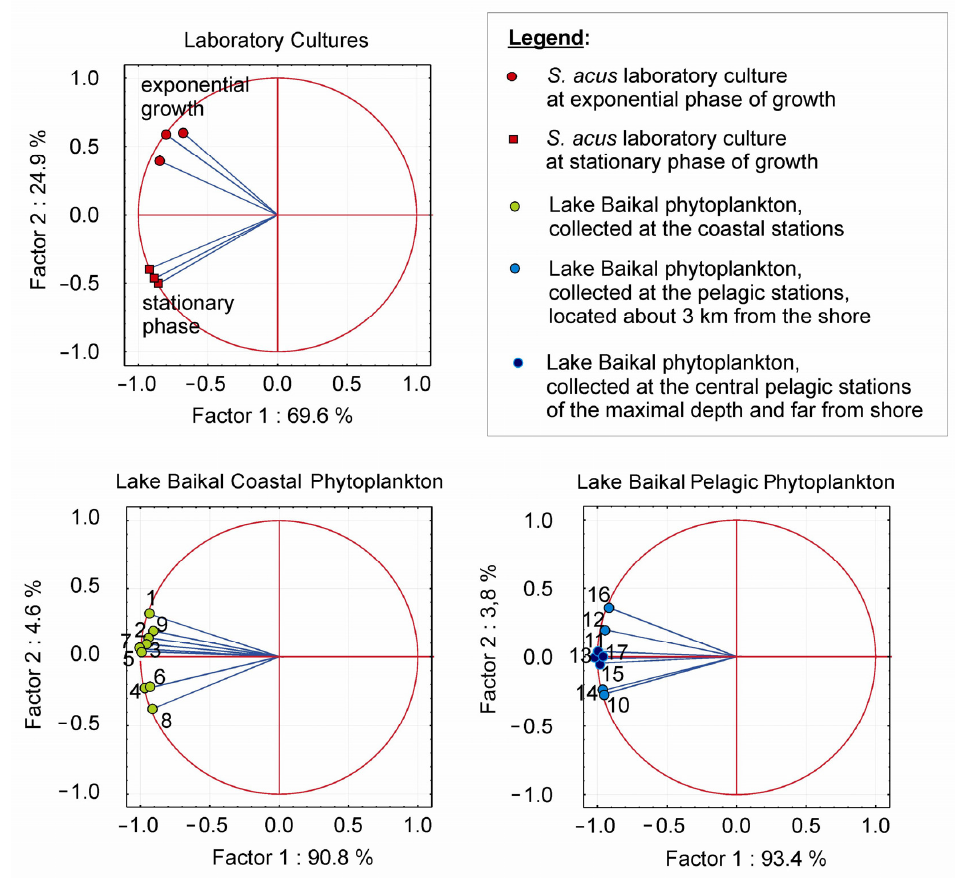
Figure 3. Analysis of Baikal phytoplankton and S. acus axenic laboratory culture by the principal component method.